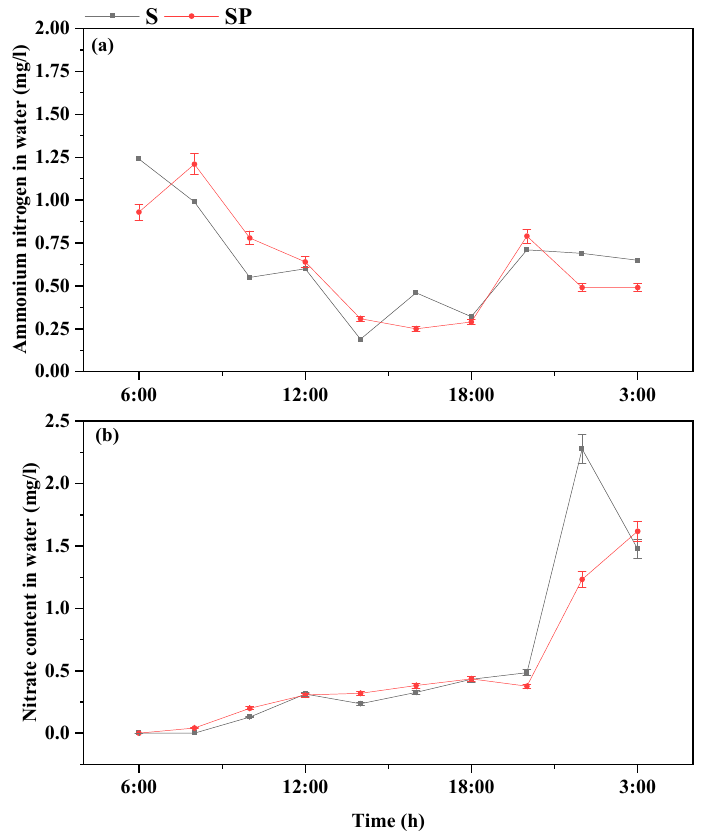
Figure 2. Diurnal variation of ammonium and nitrate contents in the agricultural drainage ditch water. ( a ) ammonium nitrogen content in water; ( b ) nitrate nitrogen content in water.